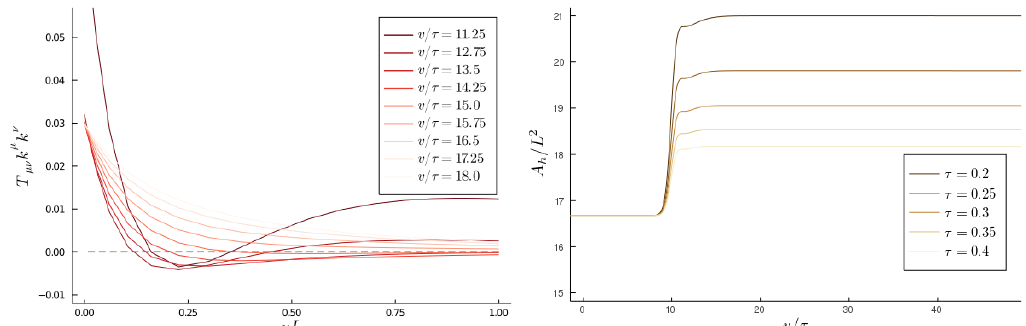
Figure 8: (Top) We check the NEC T µν k µ k ν ≥ 0 for the particular simulation of figure 7 with τ = 0.2 at different stages v /τ of the evolution. It is violated in between the boundary and the horizon. The polygonal form of the curves is a consequence of using only 20 gridpoints in the radial direction, as explained in appendix C. (Bottom) We display the size of the apparent horizon for the simulations of figure 7. All of them show a growing